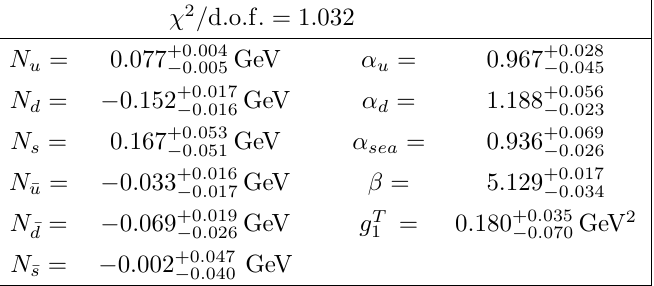
Table 2 . Fit parameters for fit 1 in table 1. The presented values is the parameter value of the fit with no Gaussian noise. The uncertainties for the replicas are generated from the parameter values which lie on the boundary of 68%